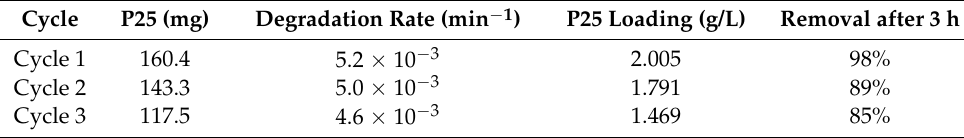
Table 3. Characteristics of groundwater and tap water.